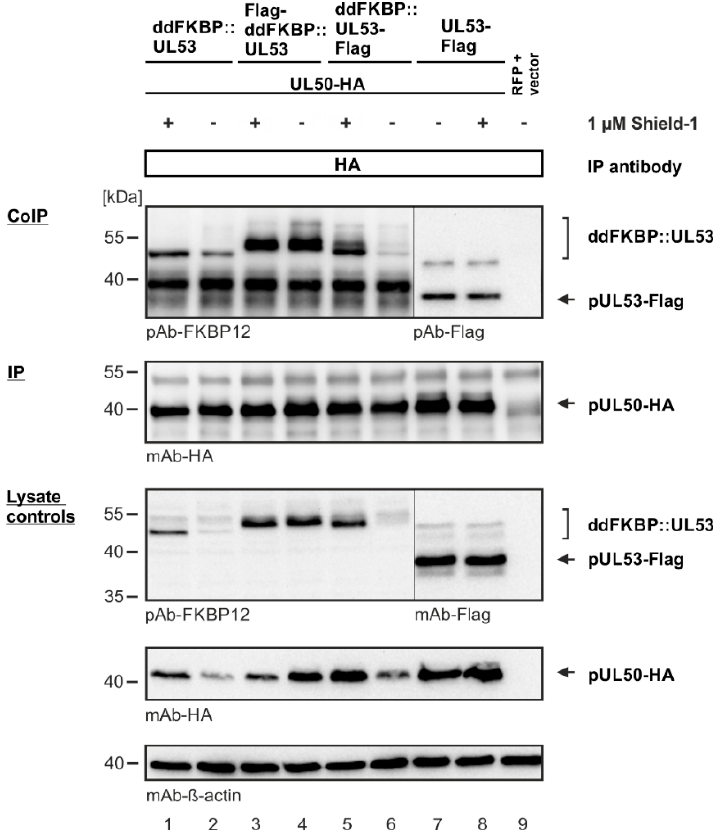
Figure 13. Interaction of ddFKBP::UL53 fusion proteins with pUL50-HA. 293T cells were transiently transfected with either the constructs coding for the three different ddFKBP::UL53 versions alone or in combination with pUL50-HA. Coexpression of the original core NEC heterodimer, pUL50-HA + pUL53-Flag, was used as a positive control; RFP + vector (pcDNA3.1) served as a negative control. To investigate protein stability, each fusion protein was expressed in the presence or in the absence of Shield-1 (1 µM). At 2 d p.t., cells were lysed, lysate controls were taken, and pUL50-HA was immunoprecipitated using mAb-HA. CoIP samples, intended to demonstrate NEC-specific protein interaction, were subjected to standard Wb analysis using specific antibodies as indicated.